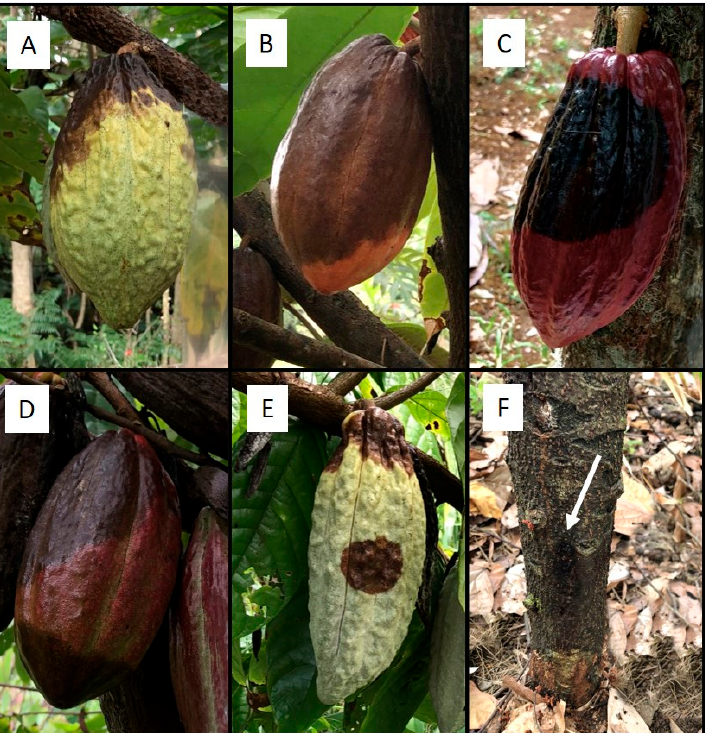
Figure 1. Symptoms of Phytophthora palmivora infection on pods and stem of Theobroma cacao in Hawaii. Necrotic lesions can originate from peduncle ( A , B ) or infection can occur at points not adjacent to the tree ( C ). In areas with higher disease incidence, lesions can develop at multiple points on a pod ( D , E ). P. palmivora also causes stem cankers ( F ) from which liquid exudes onto outer bark